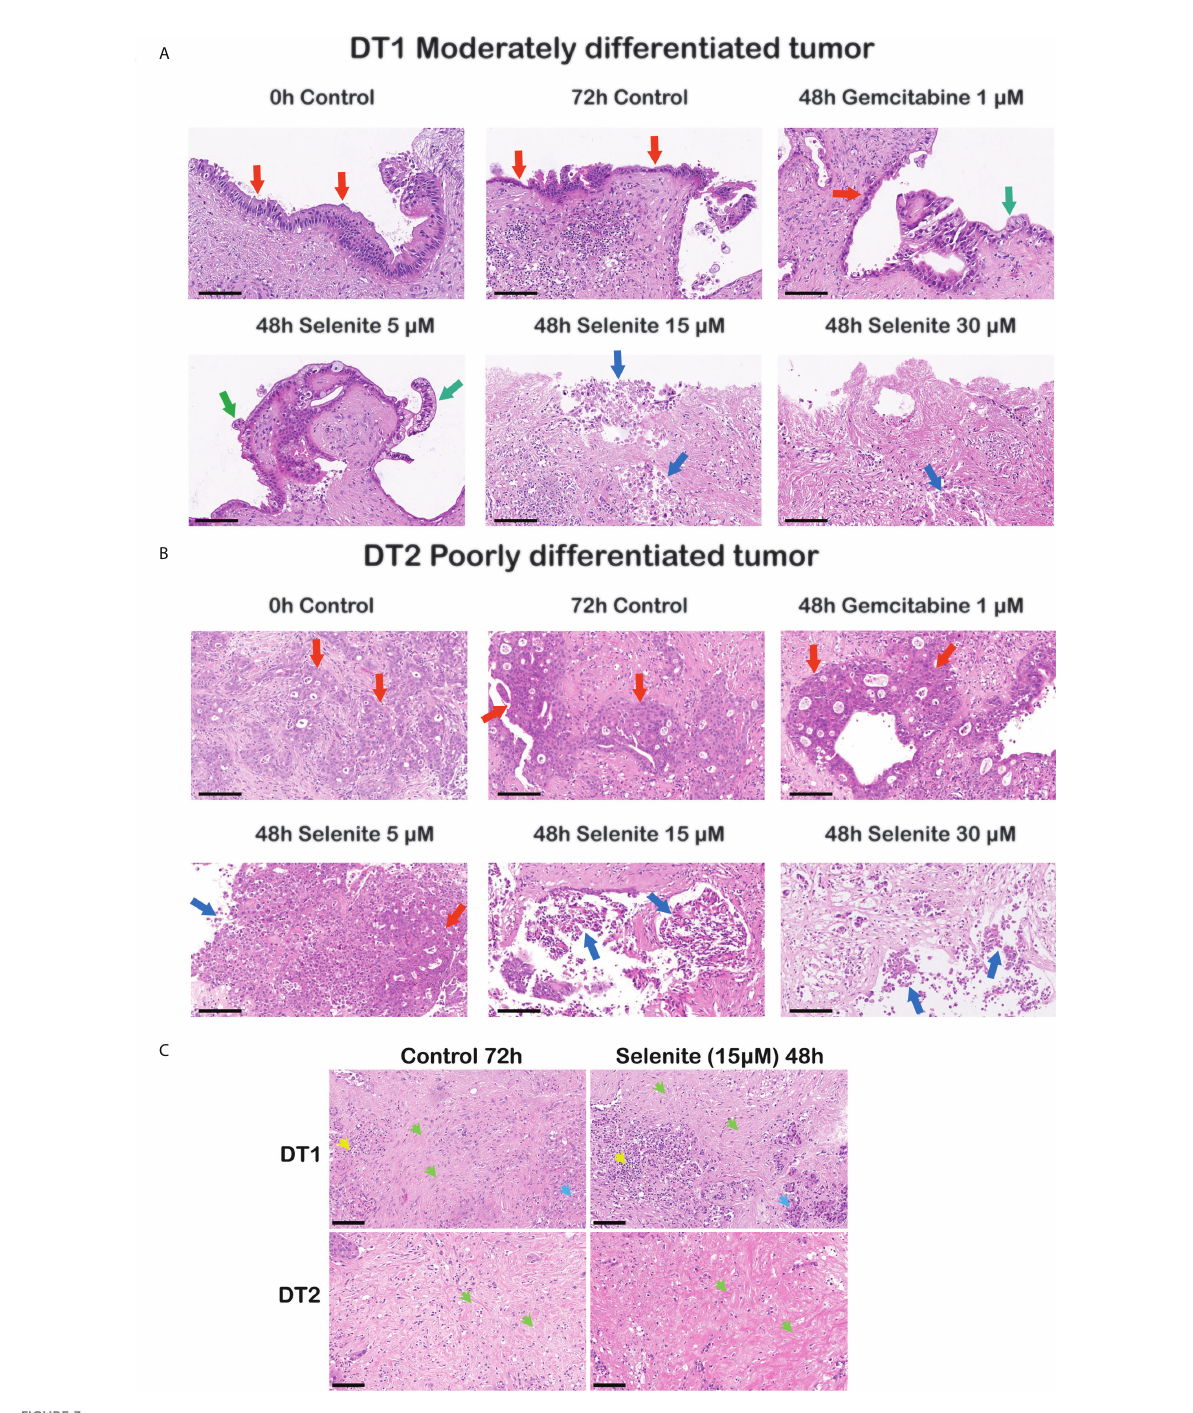
FIGURE 3 Cancer-speci fi c cytotoxicity of sodium selenite treatment in ex vivo cultured tissue slices of human PDAC. Representative photomicrographs illustrating dose-dependent cytotoxic effect in (A) a moderately and (B) a poorly differentiated PDAC upon sodium selenite treatment at increasing concentrations. Red arrows indicate viable (cylindrical, cubic or poorly differentiated) PDAC epithelium, green arrows viable clear PDAC epithelium, and blue arrows severely damaged, necro-apoptotic PDAC epithelium. Scale bars: 100 m m. (C) Representative photomicrographs showing stroma preservation in untreated (Control 72h) and sodium selenite 15 µM treated slices. Green arrows indicate preserved stroma, blue arrows remnants of pancreatic parenchyma, and yellow arrows immune cells. Scale bars: 100 m